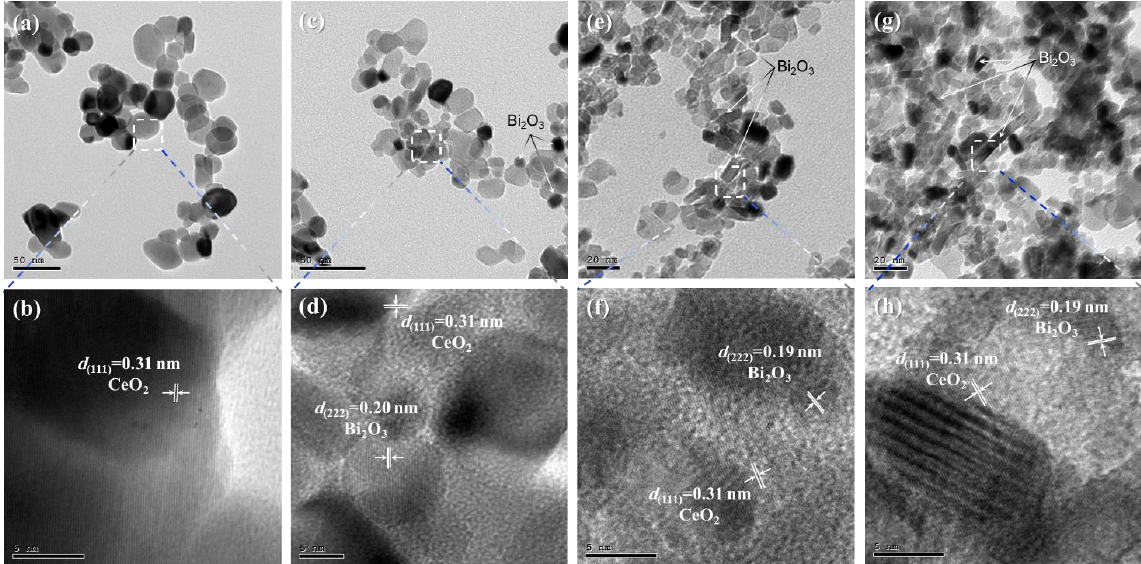
Figure 2. TEM investigations (up) and the corresponding high-resolution imaging for the selected area (down) of pure CeO 2 ( a , b ), 5% Bi 2 O 3 /CeO 2 ( c , d ), 10% Bi 2 O 3 /CeO 2 ( e , f ), and 15% Bi 2 O 3 /CeO 2 ( g , h ).